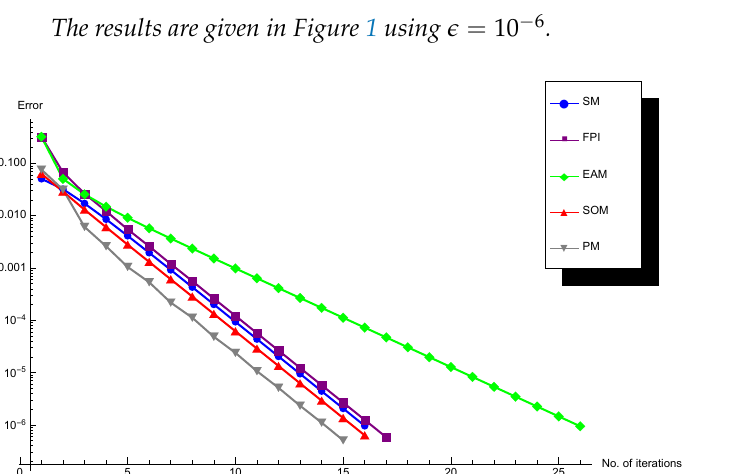
Figure 1. Convergence history for Example